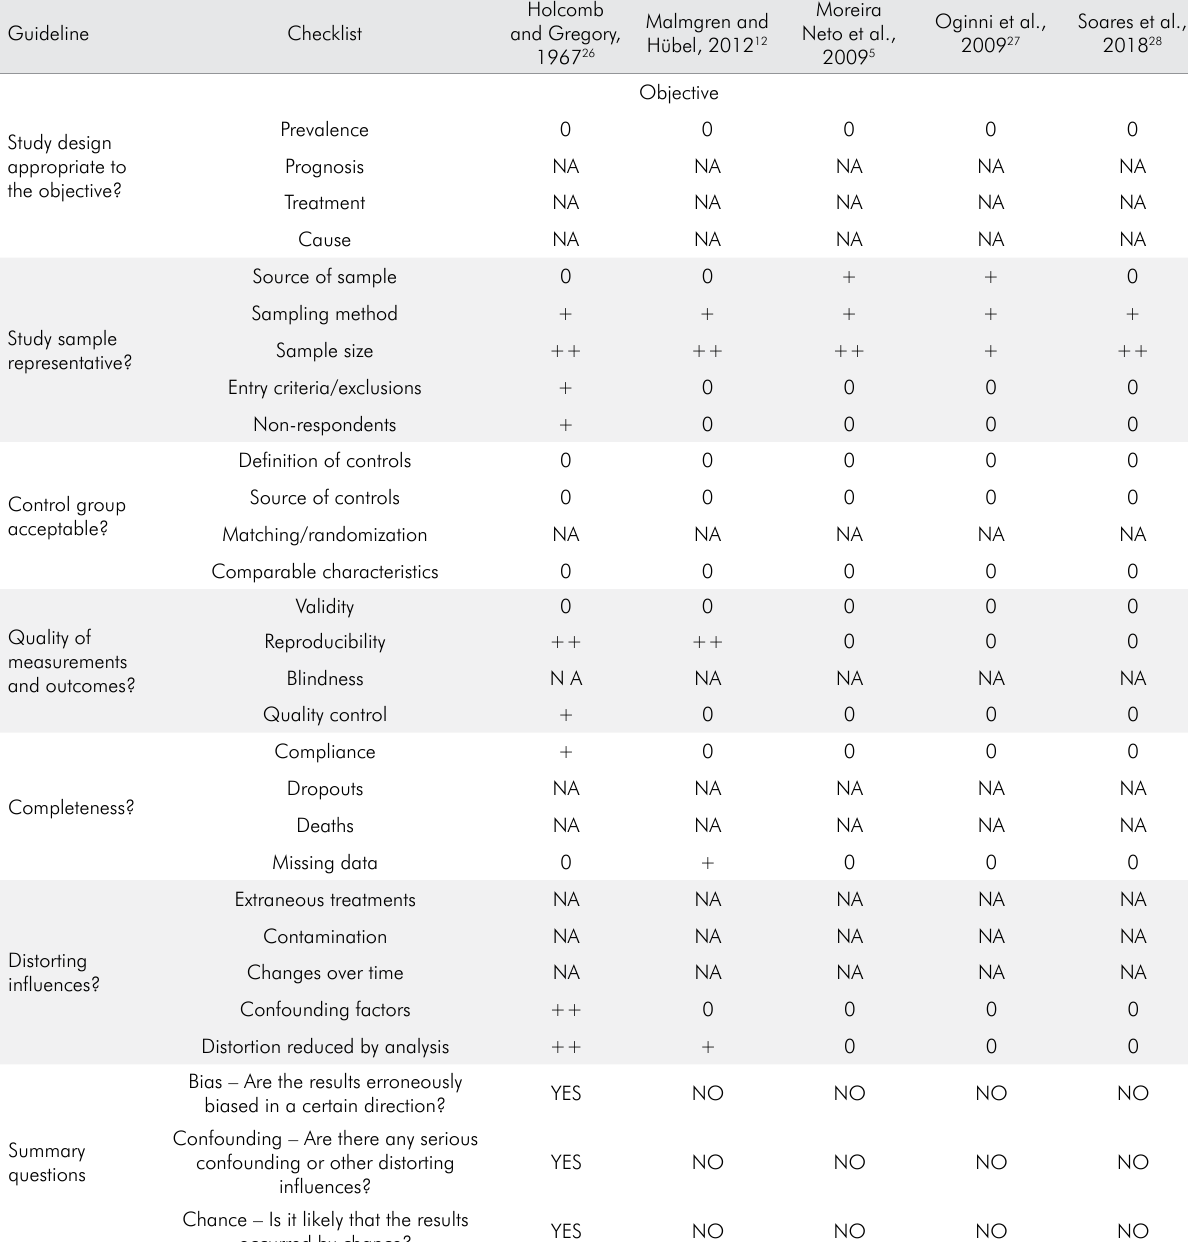
Table 4. Quality assessment Fowkes and Fulton.